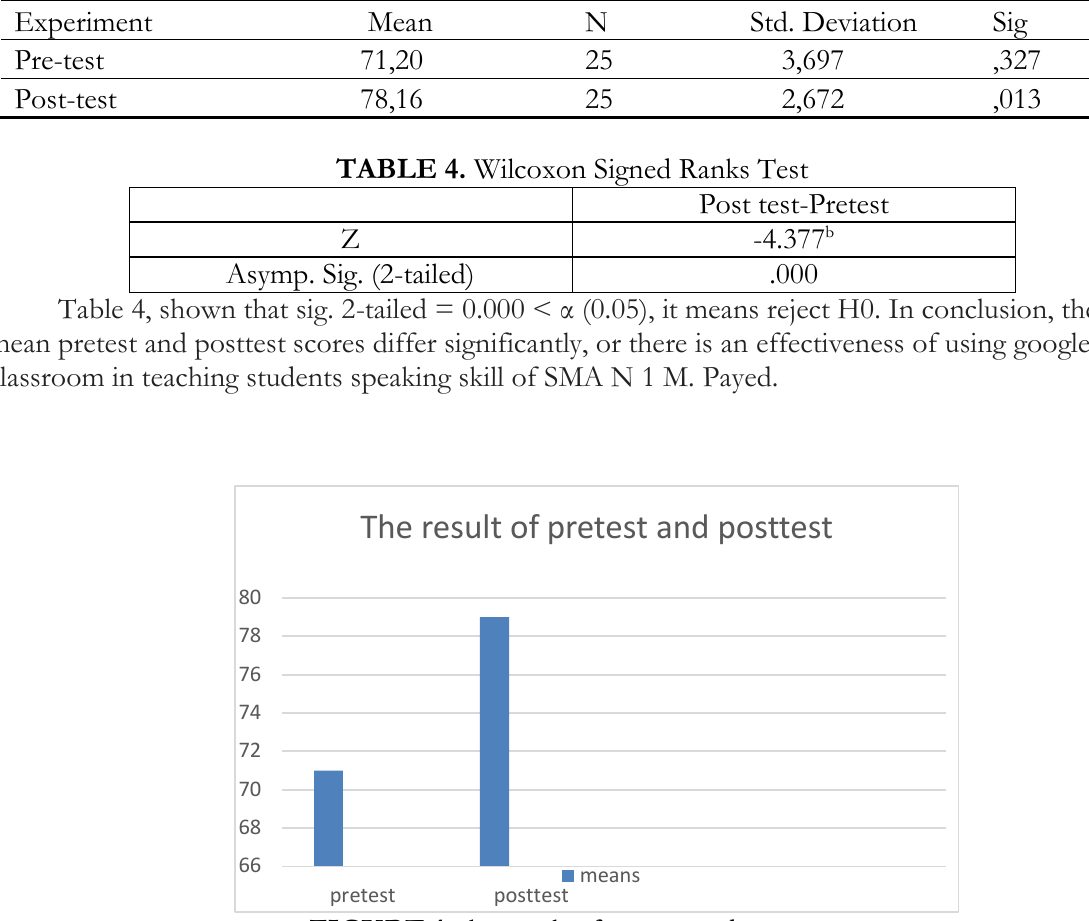
FIGURE 1 . the result of pretest and